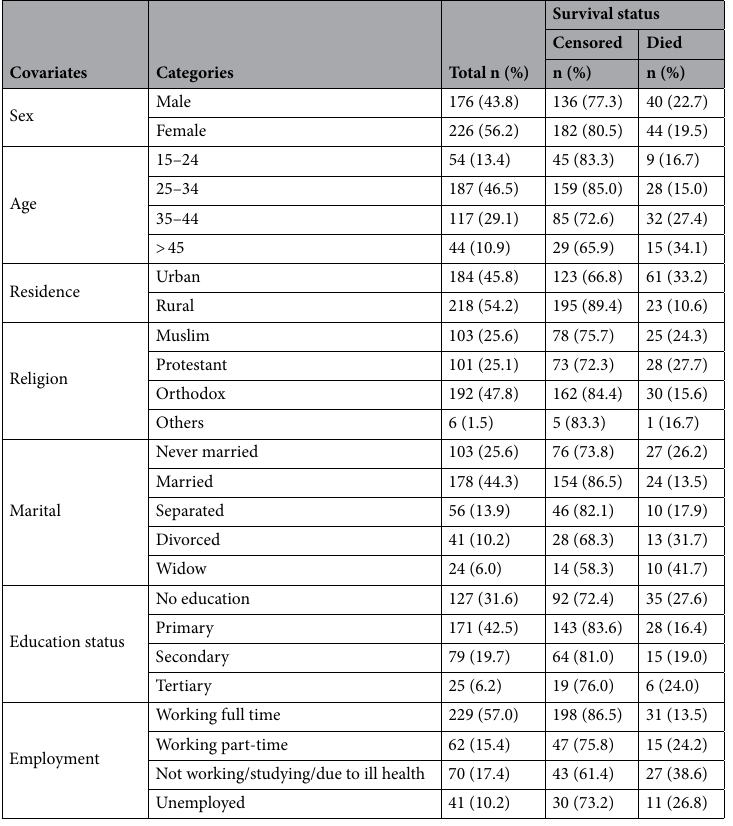
Table 1. The baseline demographic characteristics of study subjects of TB/HIV co-infected adults on ART at Mettu Karl Referral Hospital, Ethiopia, 2014–2022 (n =